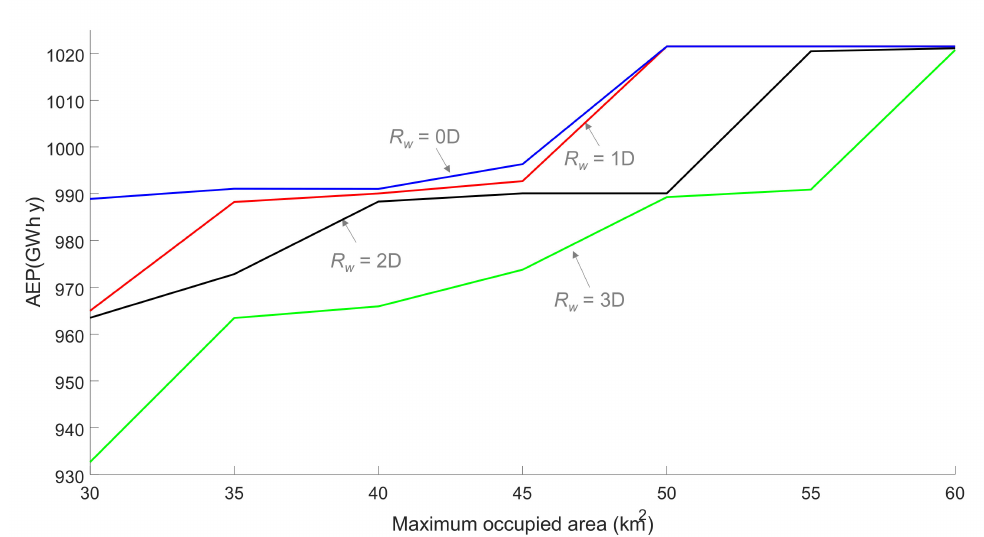
Figure 7. Evolution of the AEP for the optimum solutions obtained as a function of the maximum area occupied, for the different values of the weathervaning radius (within the range 0–3 D ) analysed in Case 2.